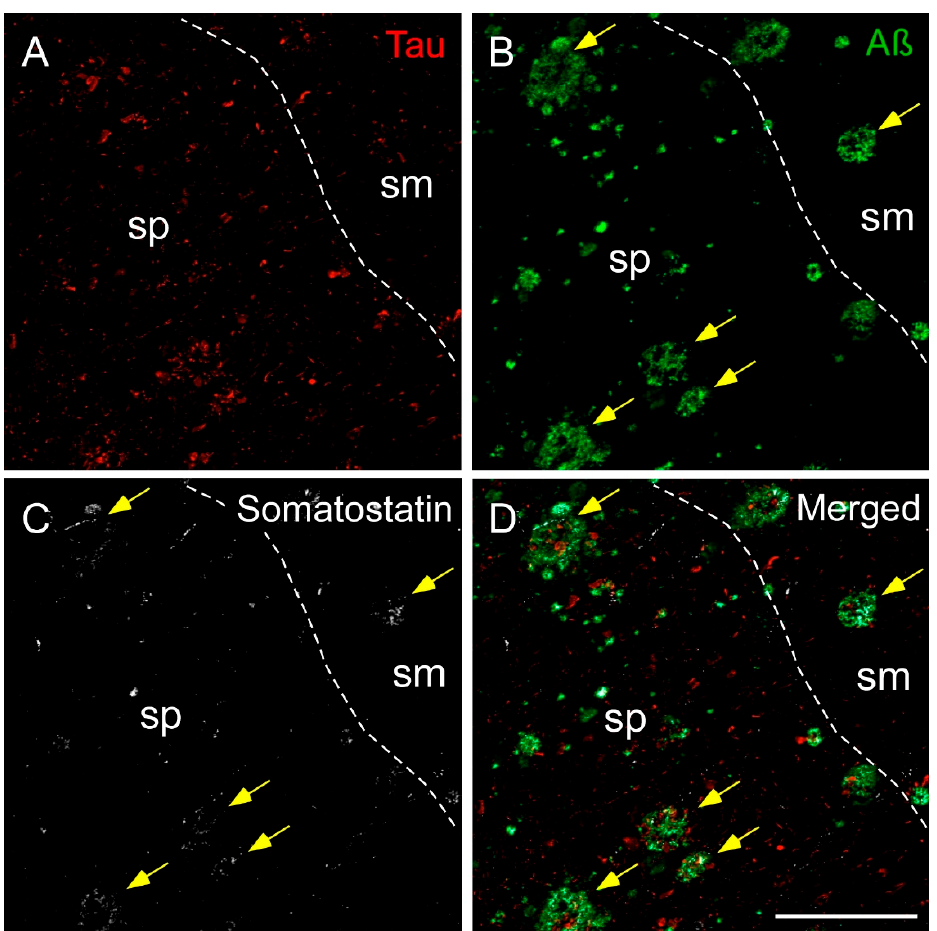
Figure 6. Immunofluorescence staining of somatostatin, tau and amyloid- β in the human hippocampus in AD. Representative images show staining in the CA1 subfield for tau ( A ), amyloid- β ( B ) and somatostatin ( C ). Tau was mainly located in the pyramidal layer (sp), whereas amyloid plaques localized to both the pyramidal layer and the molecular layer (sm). Somatostatin fibers and cell debris were found in both layers, preferentially coexpressing amyloid- β (yellow arrows) ( D ). Scale bar A – D 200 µm.